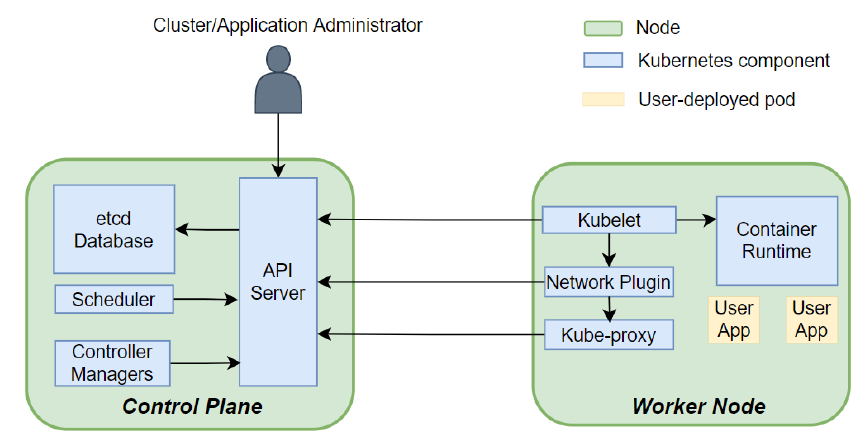
Figure 1. Kubernetes cluster